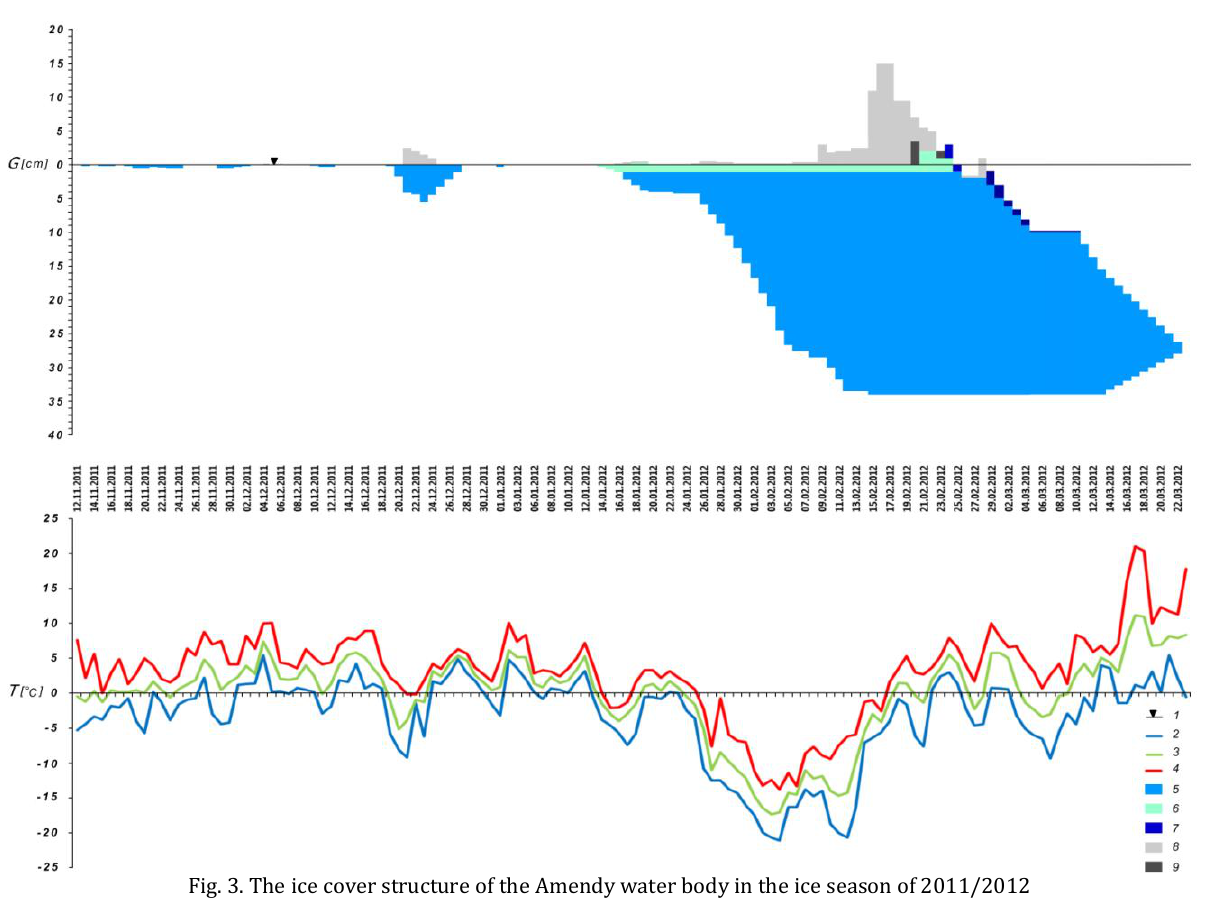
Fig. 3. The ice cover structure of the Amendy water body in the ice season of 2011/2012 1 – height of the upper part of the ice at the beginning stage, 2 – minimum daily air temperature, 3 – average daily air